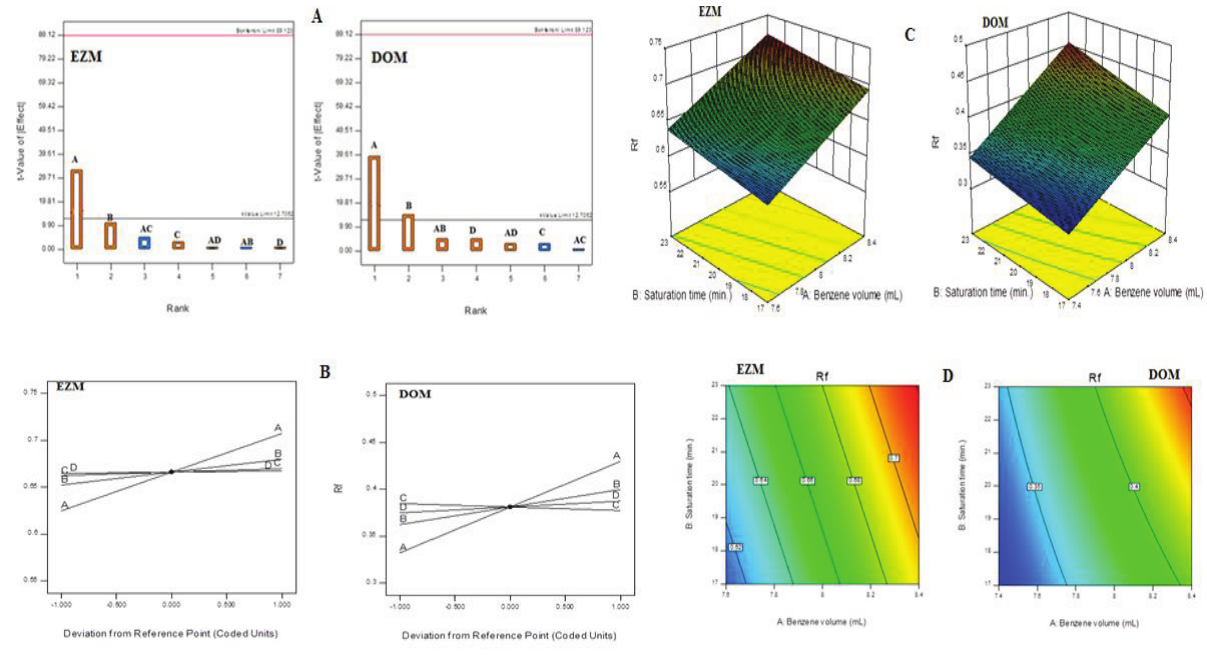
Figure 4: (A) Pareto chart, (B) Pertubation plot, (C) Three-dimensional response surface plot and (D) contour plot showing factor effects and interaction of EZM and DOM on R f .